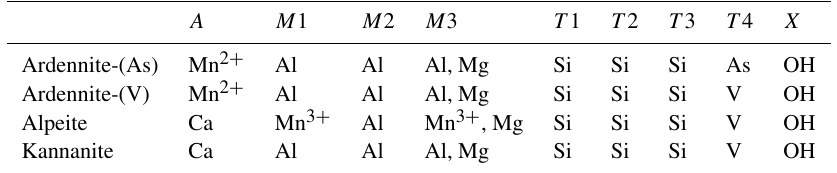
Table 4. Dominant components at the structural sites of the ardennite-group